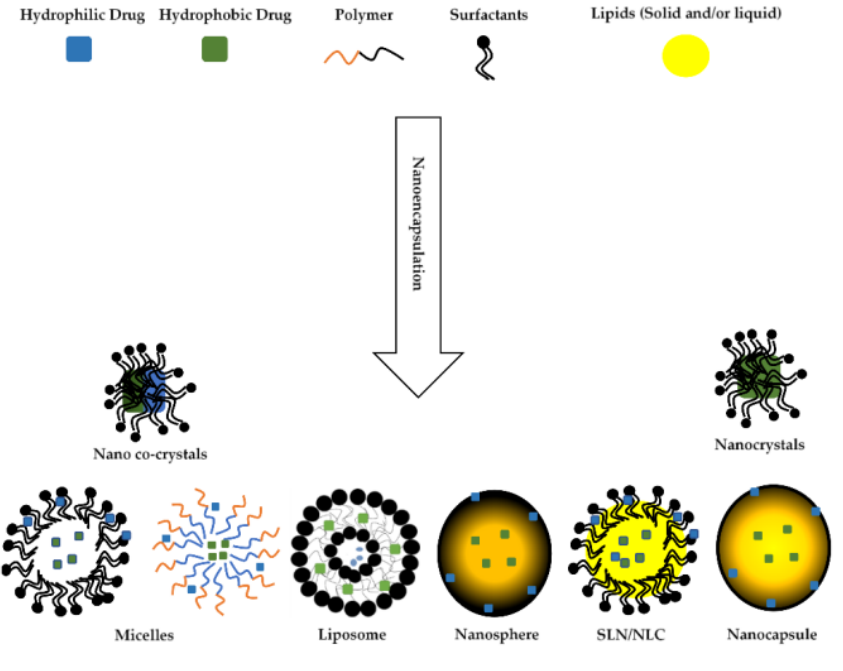
Figure 3. Summary of commonly developed and utilized biocompatible nanomaterials in ocular drug delivery. These nanocarriers possess the ability to accommodate and deliver both hydrophilic and hydrophobic drugs. [Reproduced from [33] and Nanomaterials MDPI in accordance with Creative Commons Attribution License (CC BY